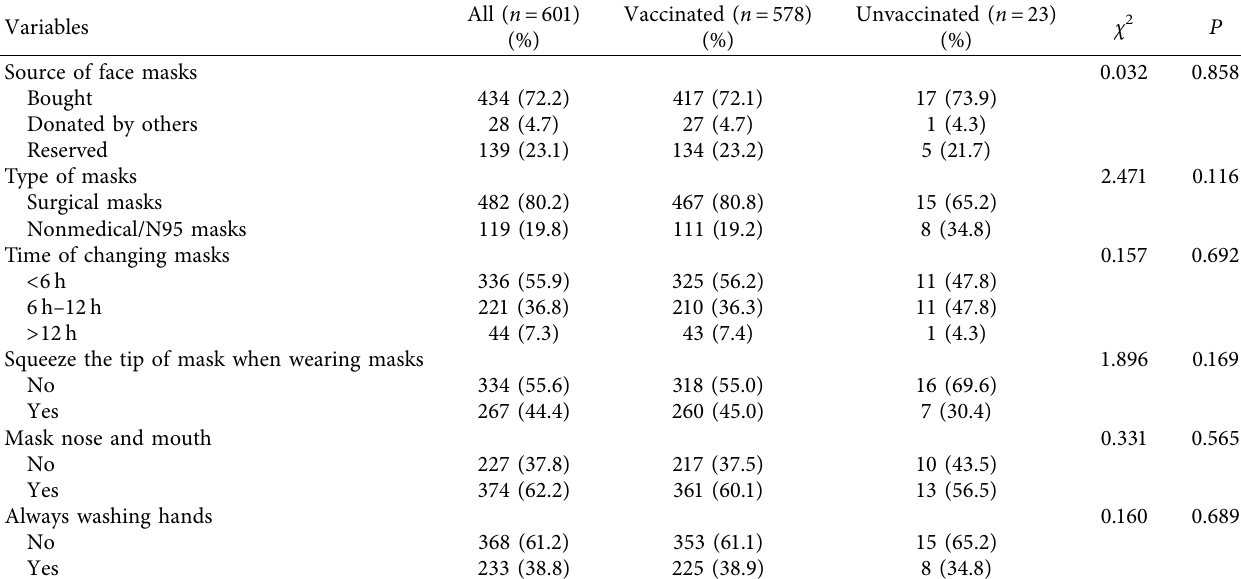
Table 3: Behaviours of participants who wore a face mask during the COVID-19